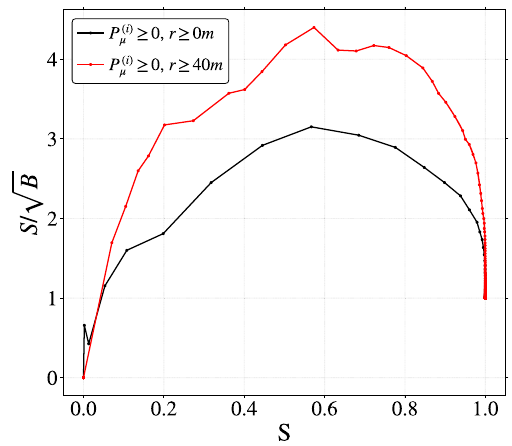
√ B achieved using selected stations as